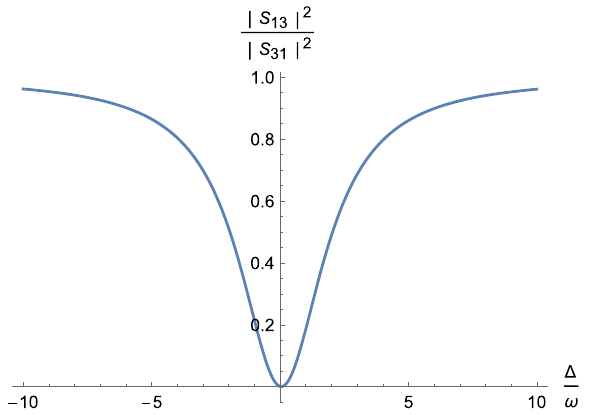
Fig. 5 The ratio of between 1 → 3 and 3 → 1 mode conversion scattering amplitudes. Due to destructive interference, set up by the phase difference parameter, the symmetry of the system is broken